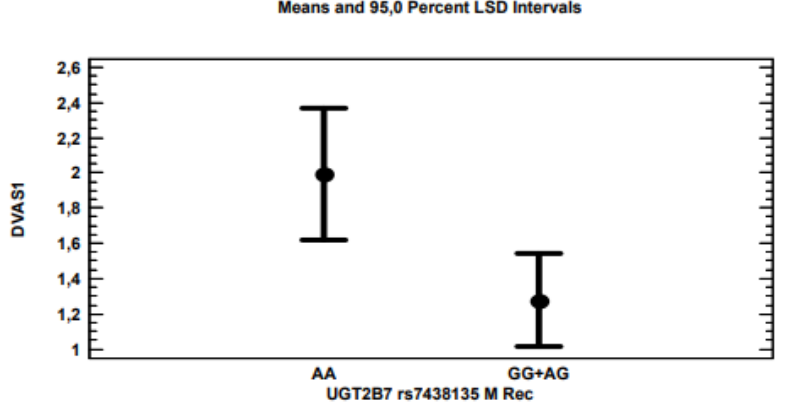
Figure 4. UBT2B7 AA homozygous patients for the UGT2B7 gene reported an average pain decrease of 2 VAS points, compared to the 1.3 VAS points of GG homozygotes or AG heterozygotes. Because the three genes did not show interactions and each patient was simultane- ously characterized by the three polymorphisms of the three genes, to explore a possible polygenic effect, patients were grouped according to the eight possible combinations of polymorphisms, as reported in Table 2. Furthermore, our results showed that the three polymorphisms associated with the greatest decrease in pain were, respectively, CC+CT for ABCB1 , CC for TRPV1 and AA for 5-UGT2B7 . In Table 2, the eight combinations were, therefore, ordered according to the number of polymorphisms, which favoured a greater decrease in pain.